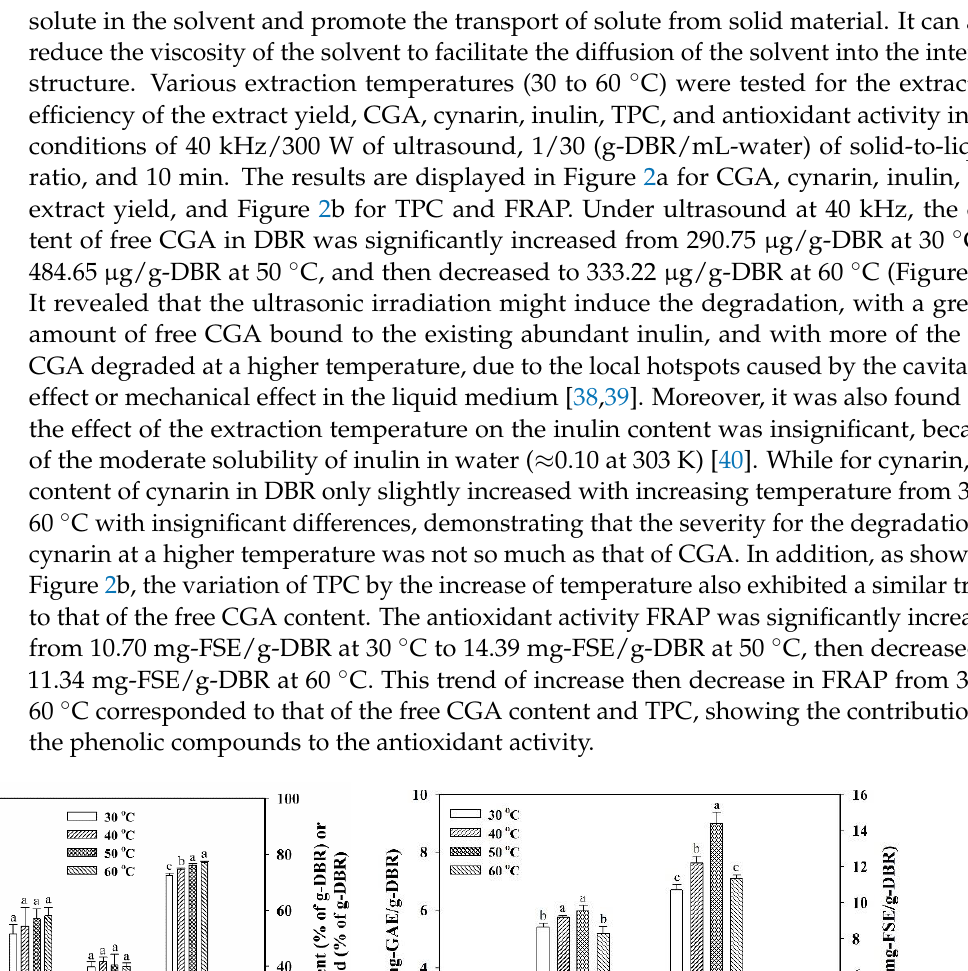
( b ) Figure 3. Effect of extraction time on the variations of ( a ) total phenolic content (TPC) and ferric- reducing antioxidant power (FRAP), and ( b ) inulin content. Conditions: 50 °C and 1/30 (g/mL-wa- ter) of solid-to-liquid ratio for extraction modes of 120 rpm of shaking (S-120), 40 kHz of ultrasound (U-40), and 120 kHz of ultrasound (U-120). Data were expressed as mean ± standard deviations from triplicate experiments.